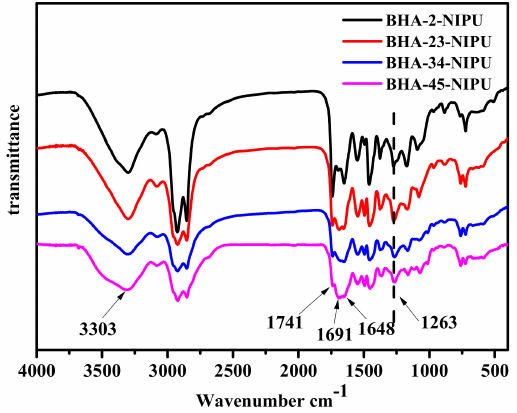
Figure 4. FTIR spectra of four